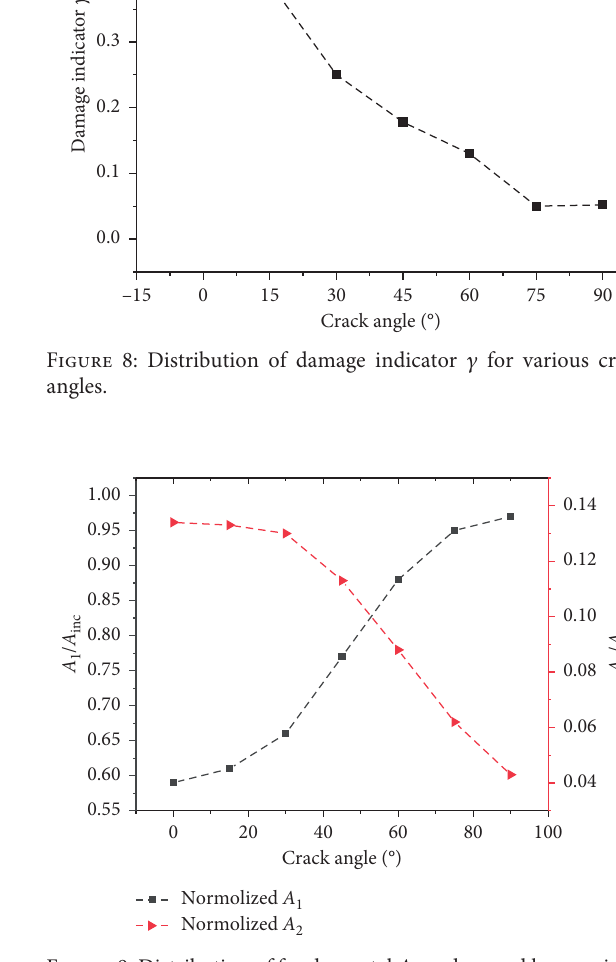
1 and second harmonic A 2